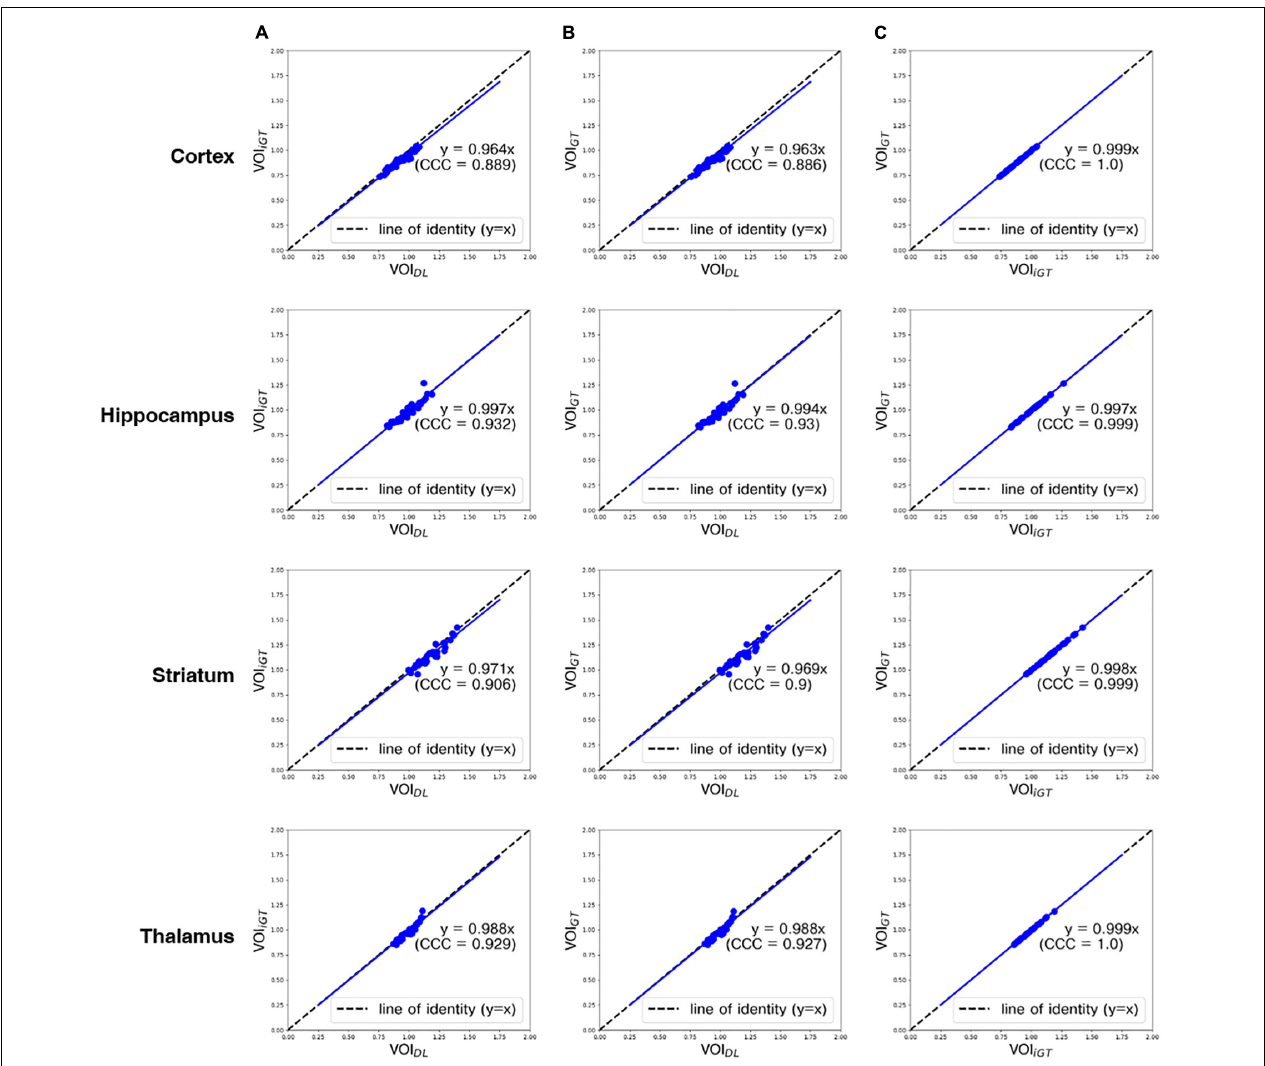
FIGURE 5 | Correlation analysis between all mean SUVRs (blue dot) obtained using VOI DL , VOI iGT , and VOI GT in all target VOIs from the first to the fourth rows (cortex, hippocampus, striatum, and thalamus, respectively). Concordance correlation coefficient represents a measure of reliability based on covariation and correspondence. The line of identity (dashed line) is depicted as a reference line. Cortex, hippocampus, striatum, and thalamus are represented sequentially from the top row. (A) Correlation analysis between mean SUVRs obtained using VOI DL and VOI iGT . (B) Correlation analysis between mean SUVRs obtained using VOI DL and VOI GT . (C) Correlation analysis between each mean SUVRs obtained using VOI iGT and VOI GT VOI DL , deep learning generated VOI; VOI iGT , deep learning label VOI; VOI GT , template-based VOI; CCC, concordance correlation